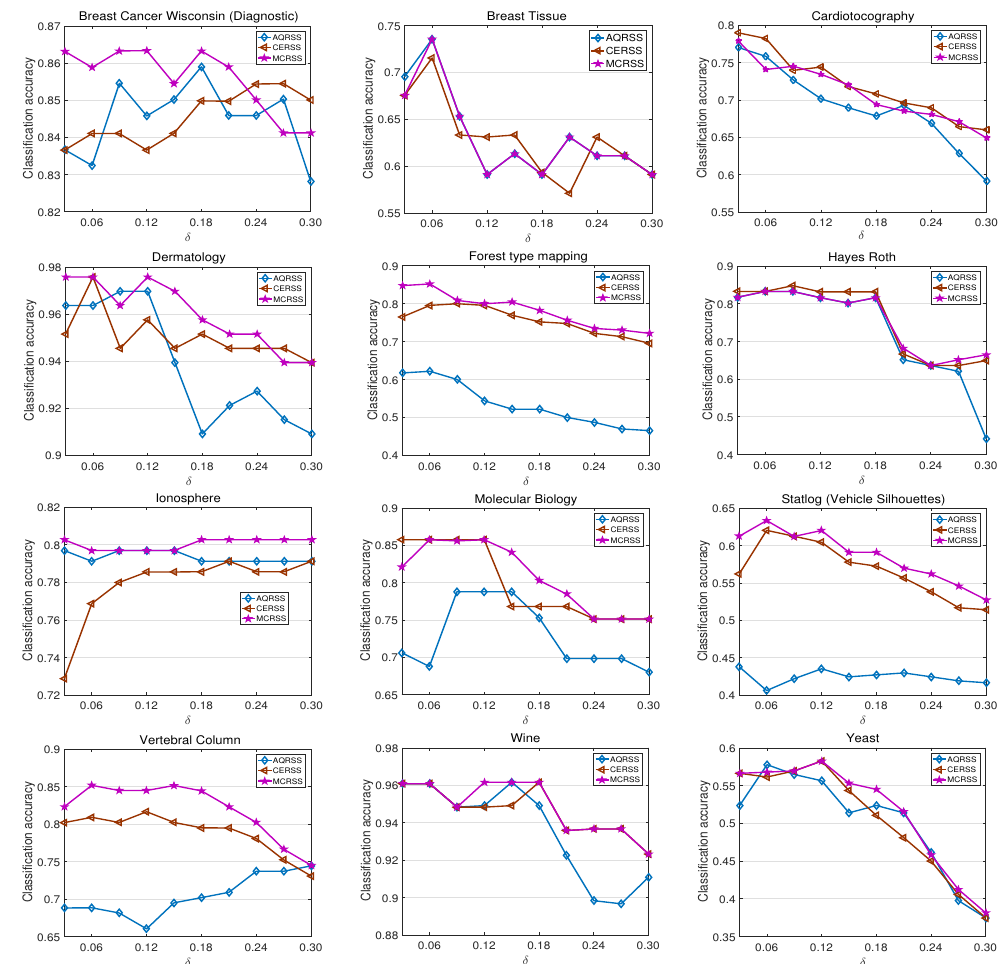
Figure 3. Comparisons of classification